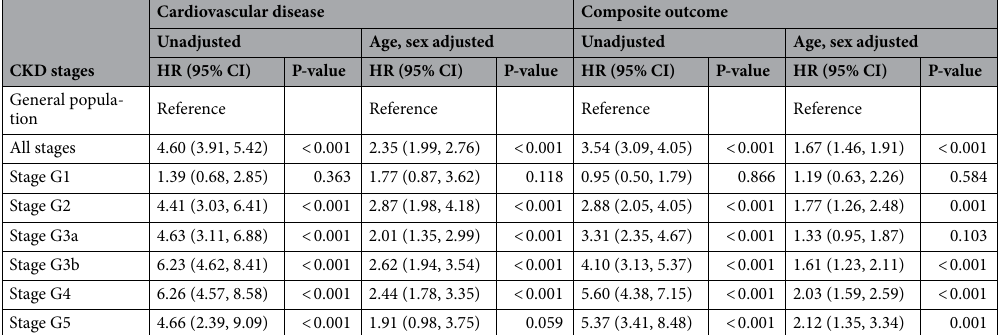
Table 4. Age and sex adjusted hazard ratios of outcome risks in the KNOW-CKD cohort compared to the general population using multivariate Cox regression analysis. CI confidential interval, CKD chronic kidney disease, HR hazard ratio, UPCR urine protein-to-creatinine